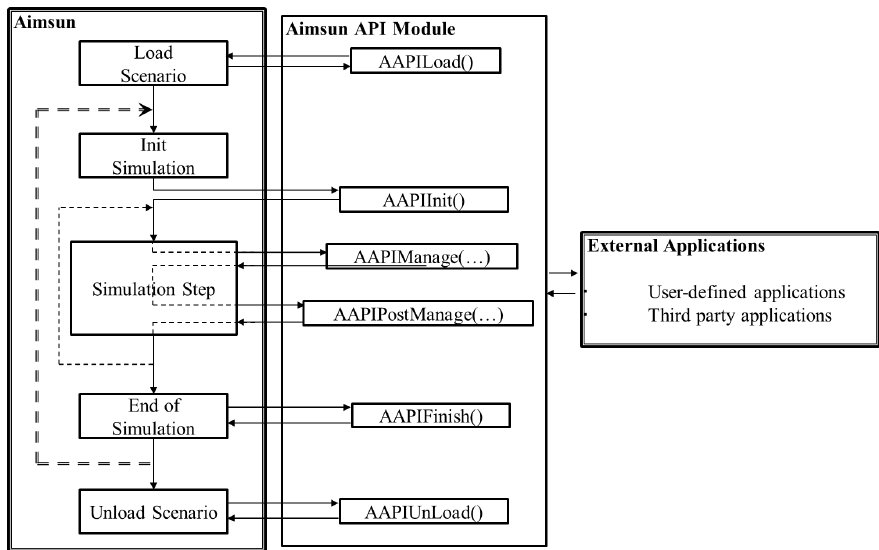
Fig 3. API module application